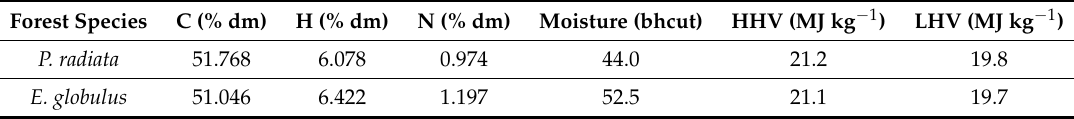
Table 5. Average values of moisture (wt. %) and heating values (MJ kg − 1 ) mass forestry of woody litter (WL). HHV: higher heating